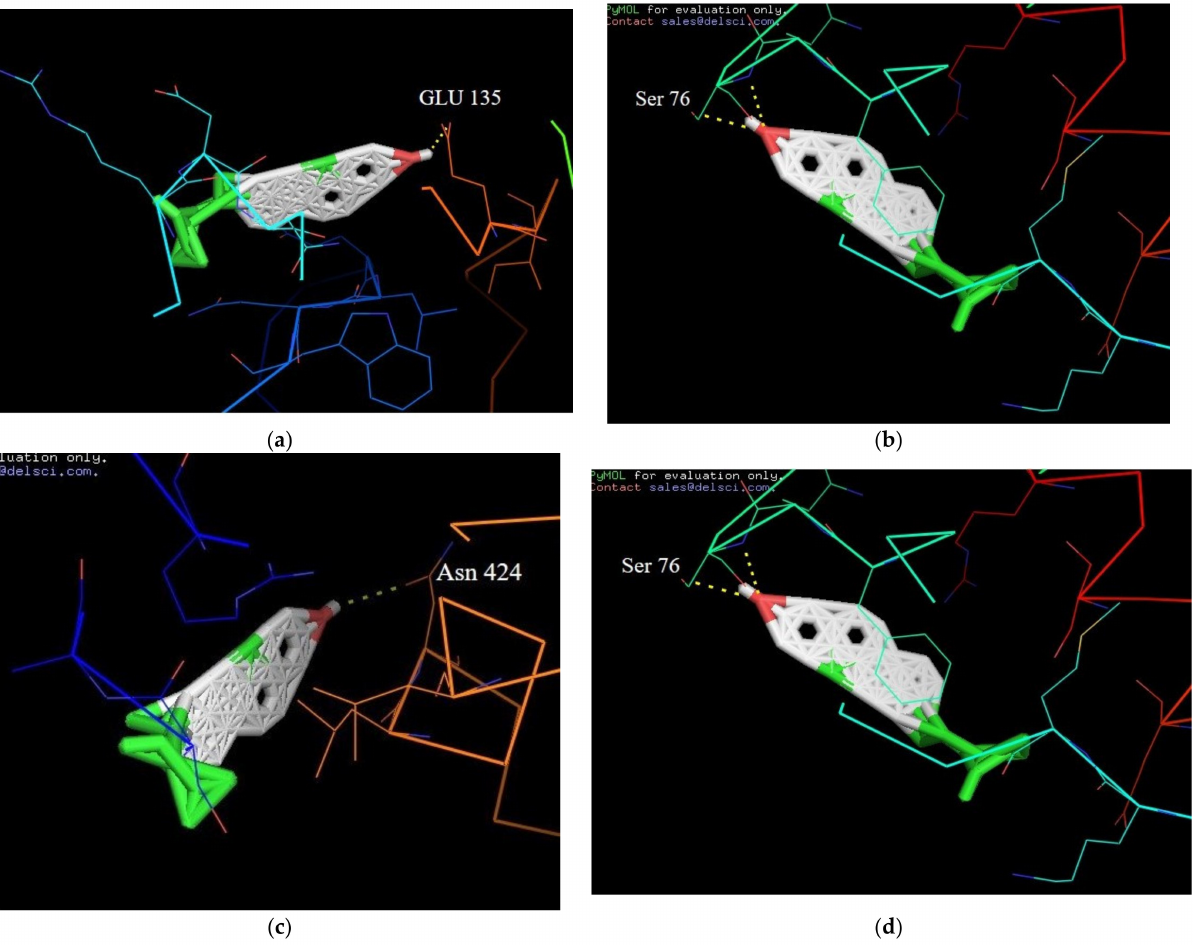
Figure 14. ( a ) Docked orientation of β -sitosterol with additional representation of corresponding amino acids of the TNF- α protein; ( b ) Docked orientation of β -sitosterol with additional representation of corresponding amino acids of the IL-6 protein; ( c ) Docked orientation of β -sitosterol with additional representation of corresponding amino acids of the PPAR- γ protein; ( d ) Docked orientation of β -sitosterol with additional representation of the corresponding amino acids of the JNK-3 protein. Abbreviations: Glutamine (Glu); Serine (Ser); Asparagine